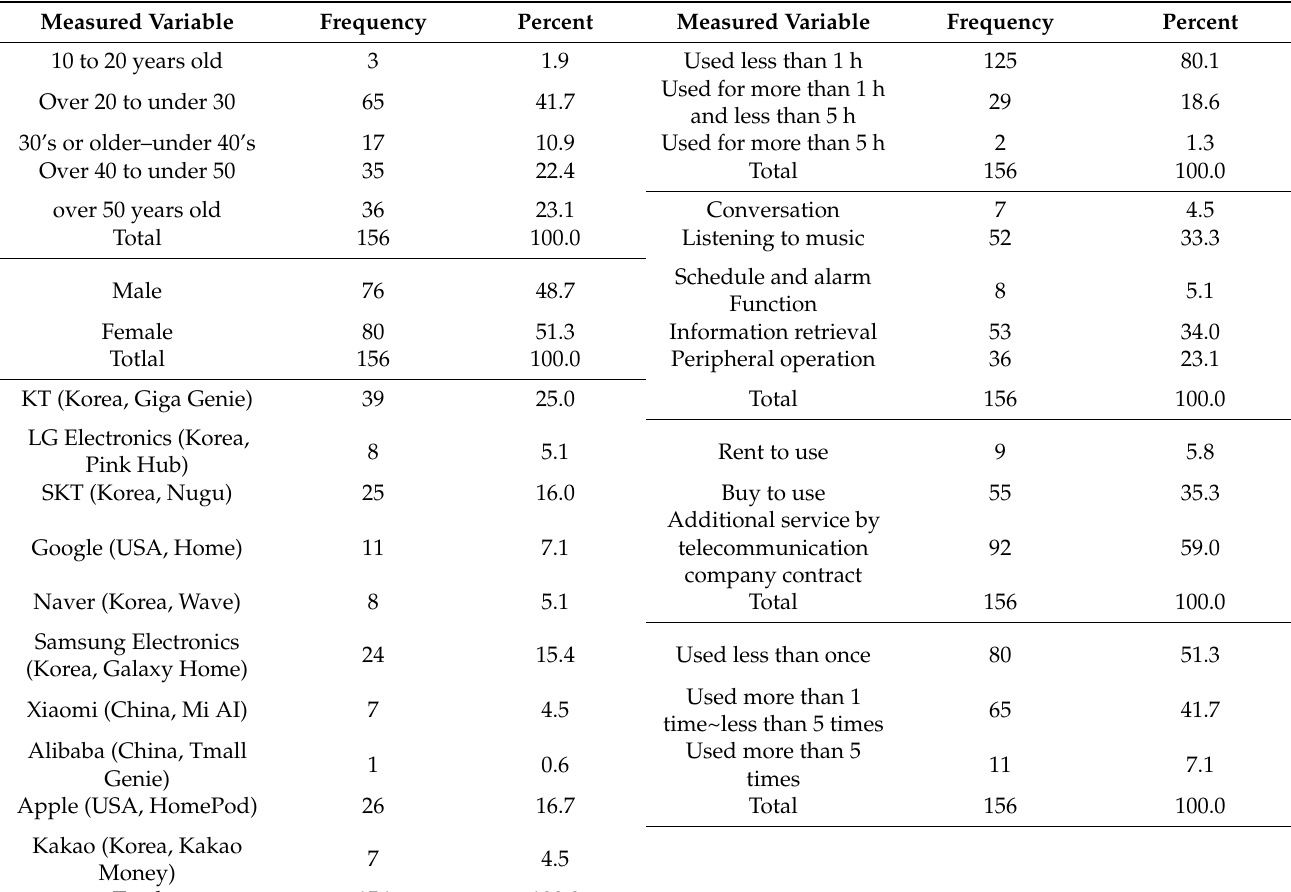
Table 2. Result of analyzing the characteristics of